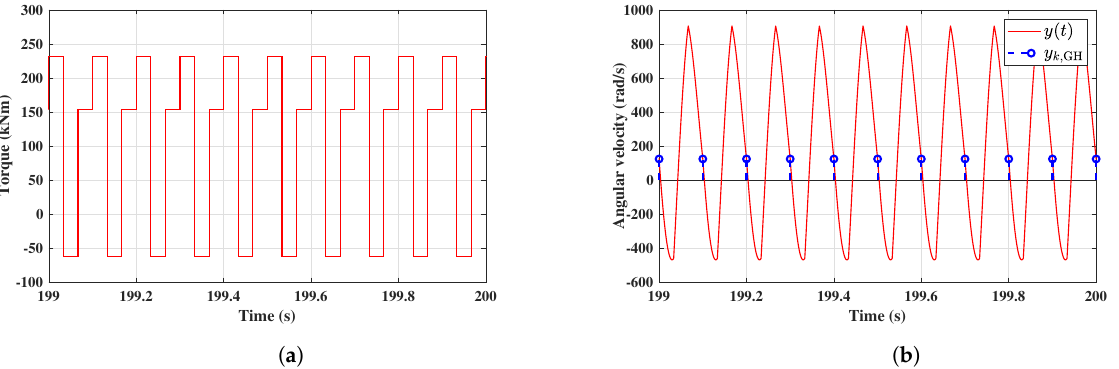
Figure 9. ( a ) Control input generated by a GH; ( b ) generator angular velocity ω g ( t ) and its sampled signal ω g ,GH . The possibly undesirable intersample behavior can be avoided by using GS instead of SS at the output side and using ZOH at the input side. To demonstrate this, we follow